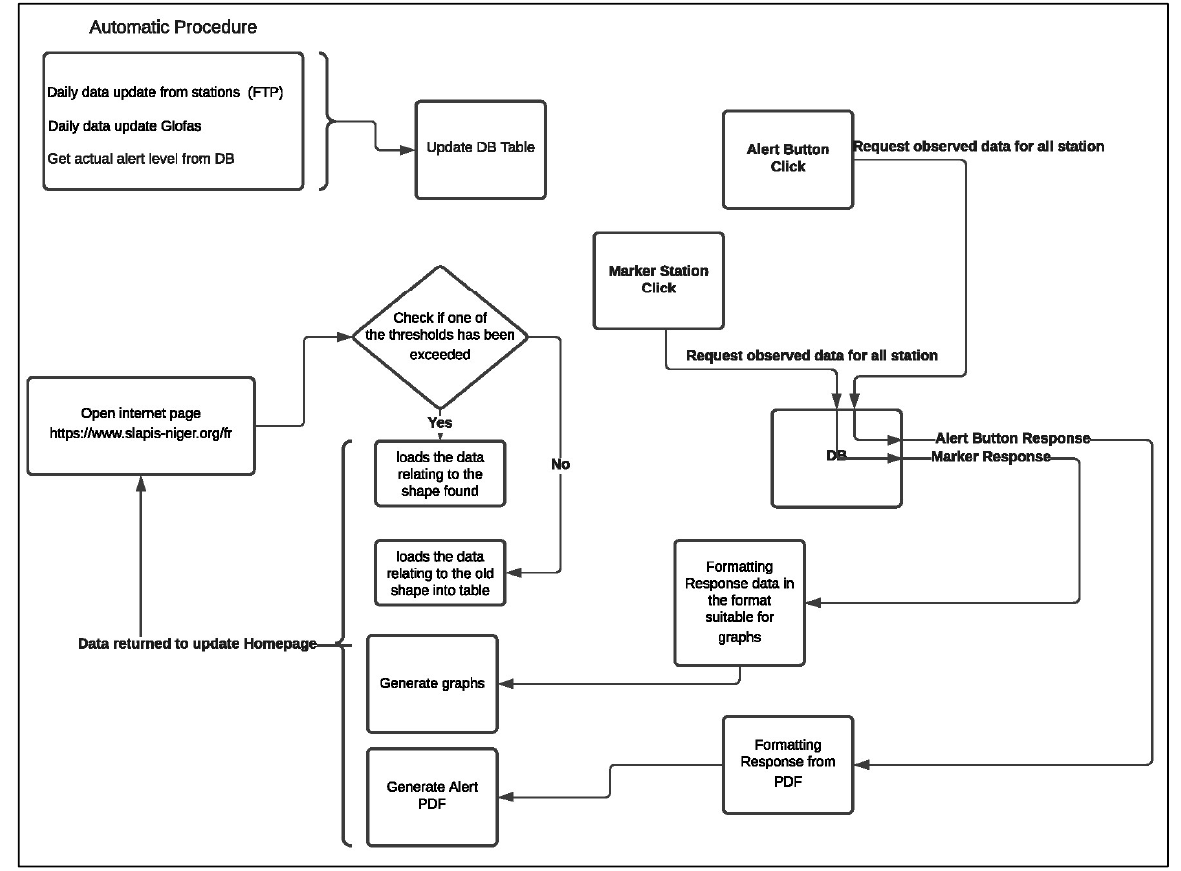
ISPRS Int. J. Geo-Inf. 2022 , 11 , x FOR PEER REVIEW